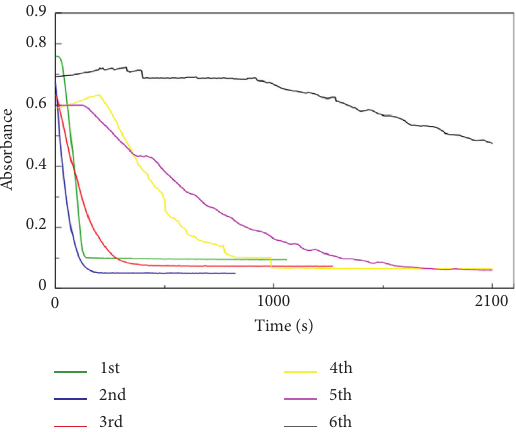
Figure 11: Kinetics of the catalytic reduction of 4-NP in the presence of Ag/SiO